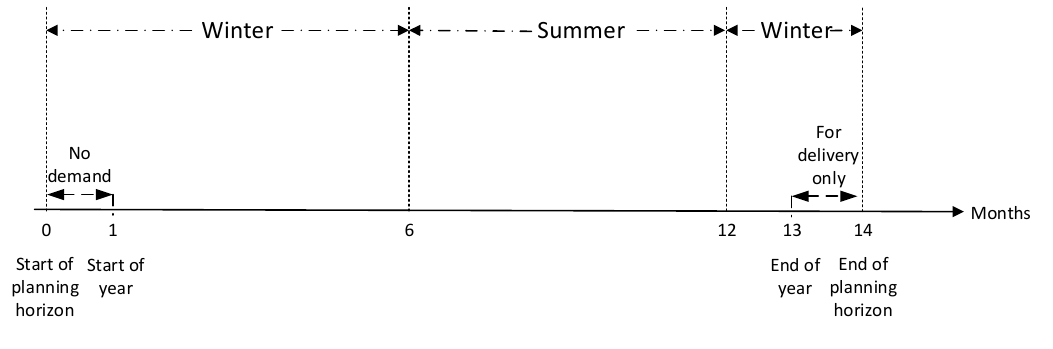
Figure 7. The complete planning